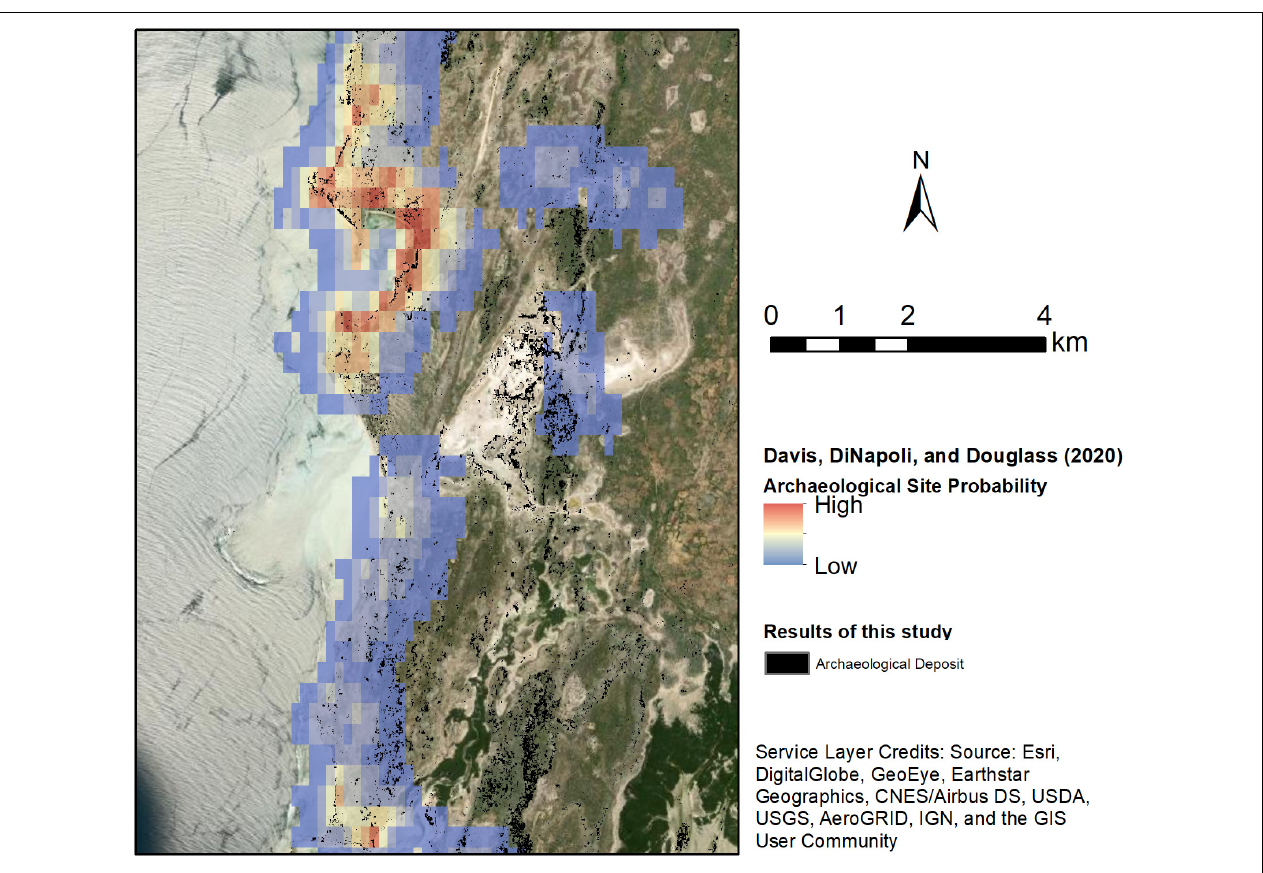
FIGURE 7 | Comparison between predictive modeling results of Davis et al. (2020b) and this study. The previous study investigated settlement distribution via environmental and social drivers, while this study looked at long-term ecological effects of settlement activity. Notice that both models detect or predict archaeological activity in many of the same locations. The areas ranked with the highest likelihood by Davis et al. (2020b) also contain some of the oldest recorded evidence of human occupation in this region ( ∼ 2,500–3,000 cal year